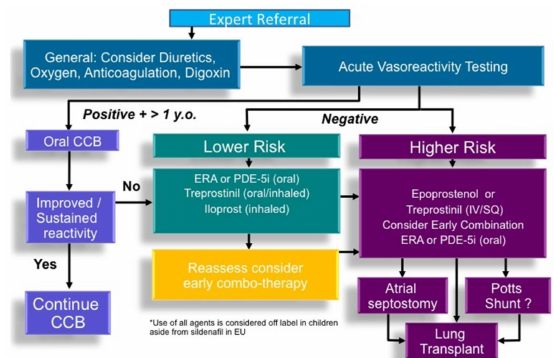
Figure 11. Adapted treatment algorithm proposed in the management of pediatric patients with idiopathic or heritable pulmonary arterial hypertension. This may be translatable to other patients with pulmonary hypertension. CCB, calcium channel blocker; ERA, endothelin receptor antagonist; PDE-5i, phosphodiesterase 5 inhibitor